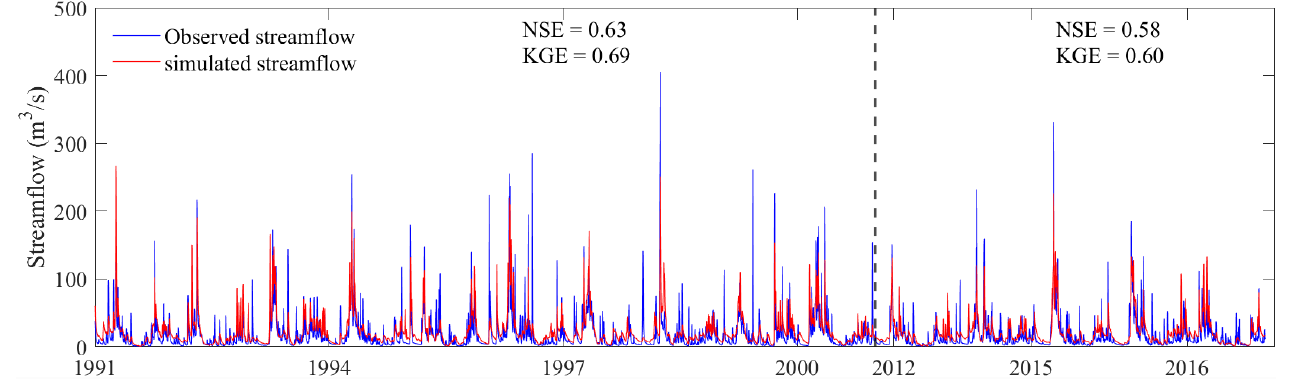
Figure 3. Comparison of time series of the observed and simulated streamflow hydrographs at station 030282.